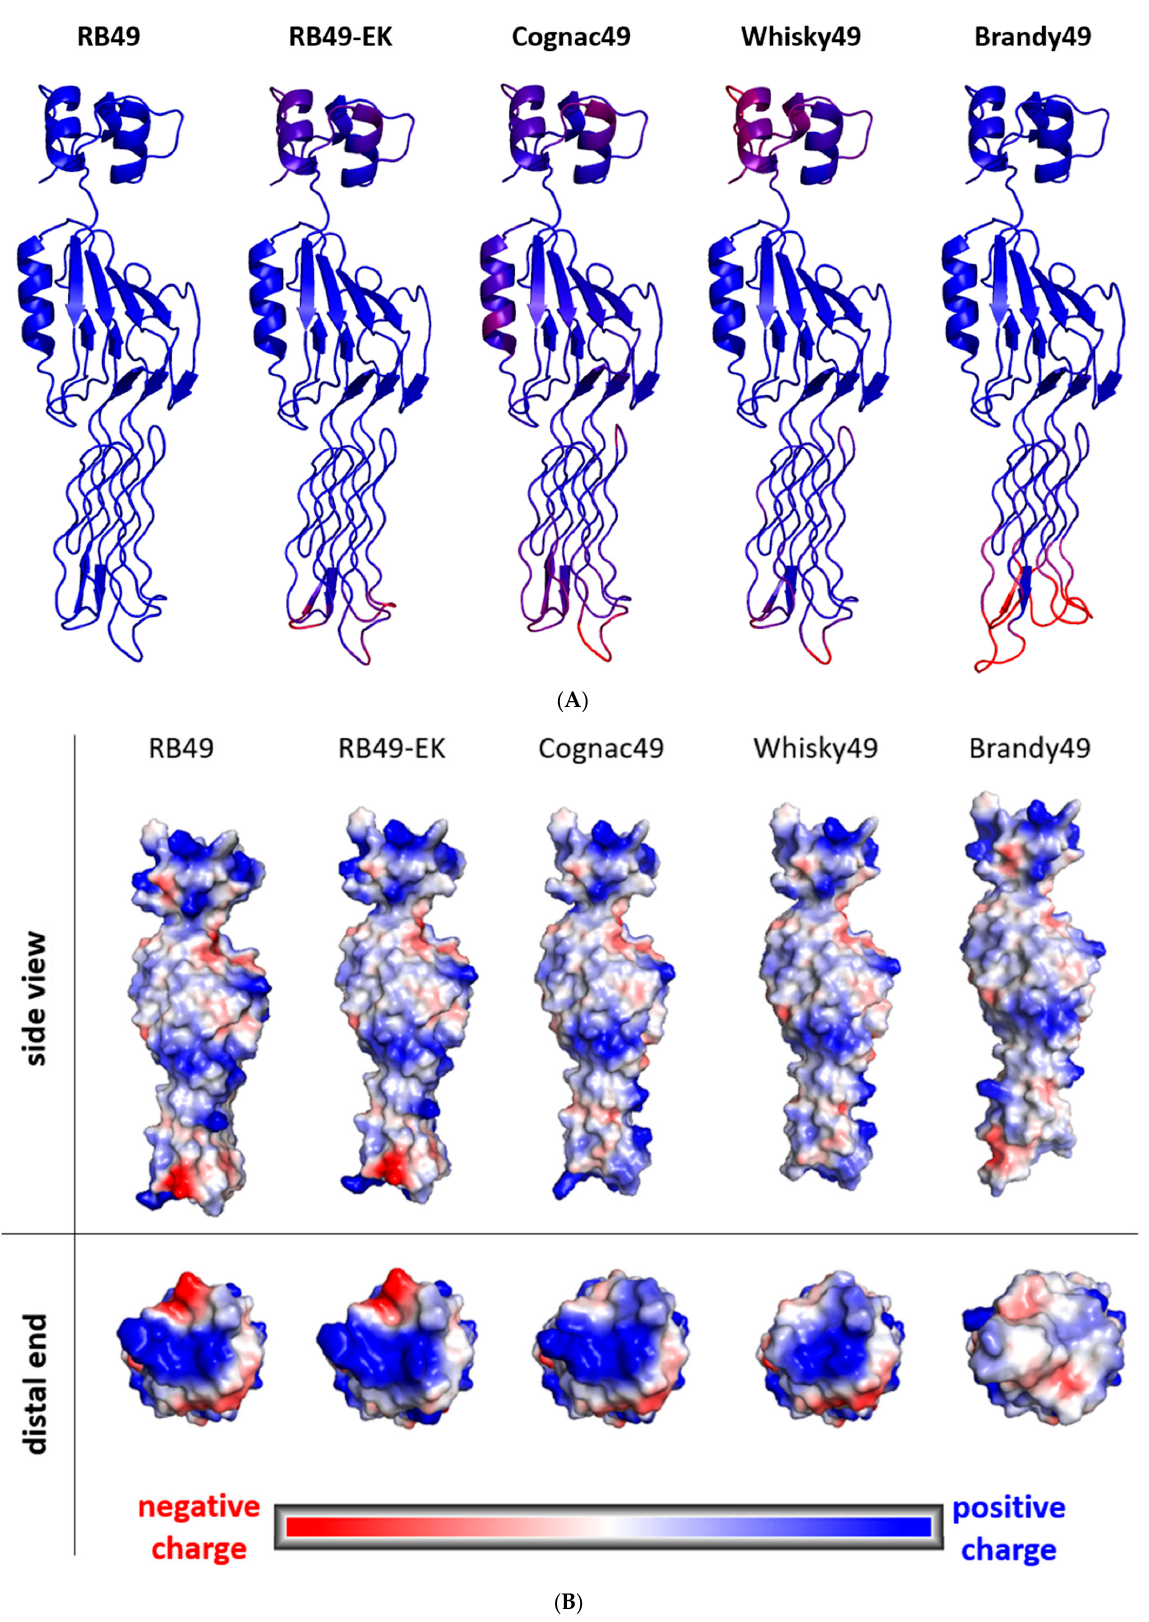
Figure 2. AlphaFold modelling of the structures of gp38 from RB49-like bacteriophages. ( A ) Backbone view. ( B ) Surface view. The color scale reflects the surface electric charge.